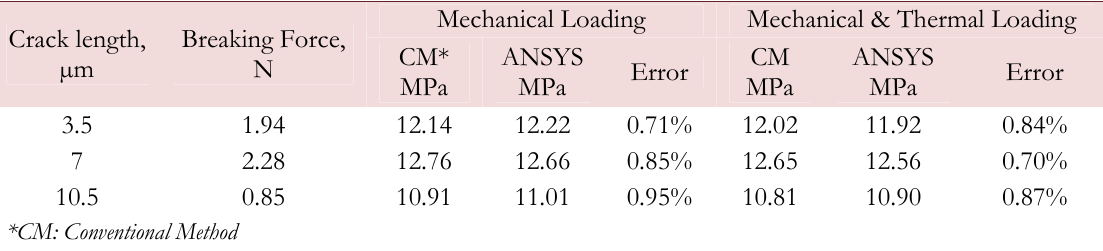
Table 2: Maximum Von Misses stress distribution and breaking force for different